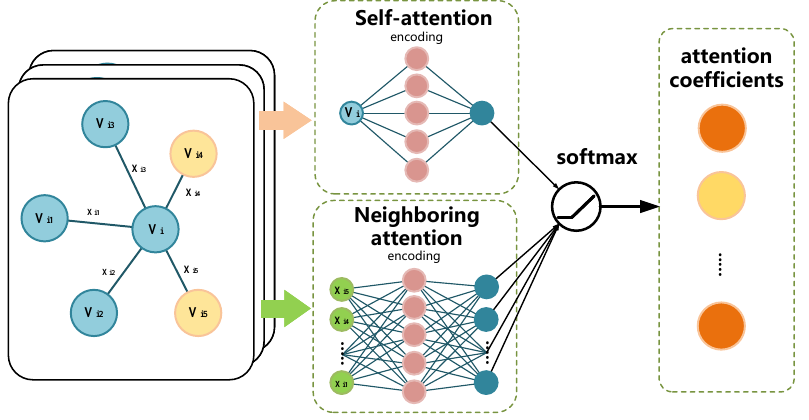
Figure 7. Structure of graph attention neural